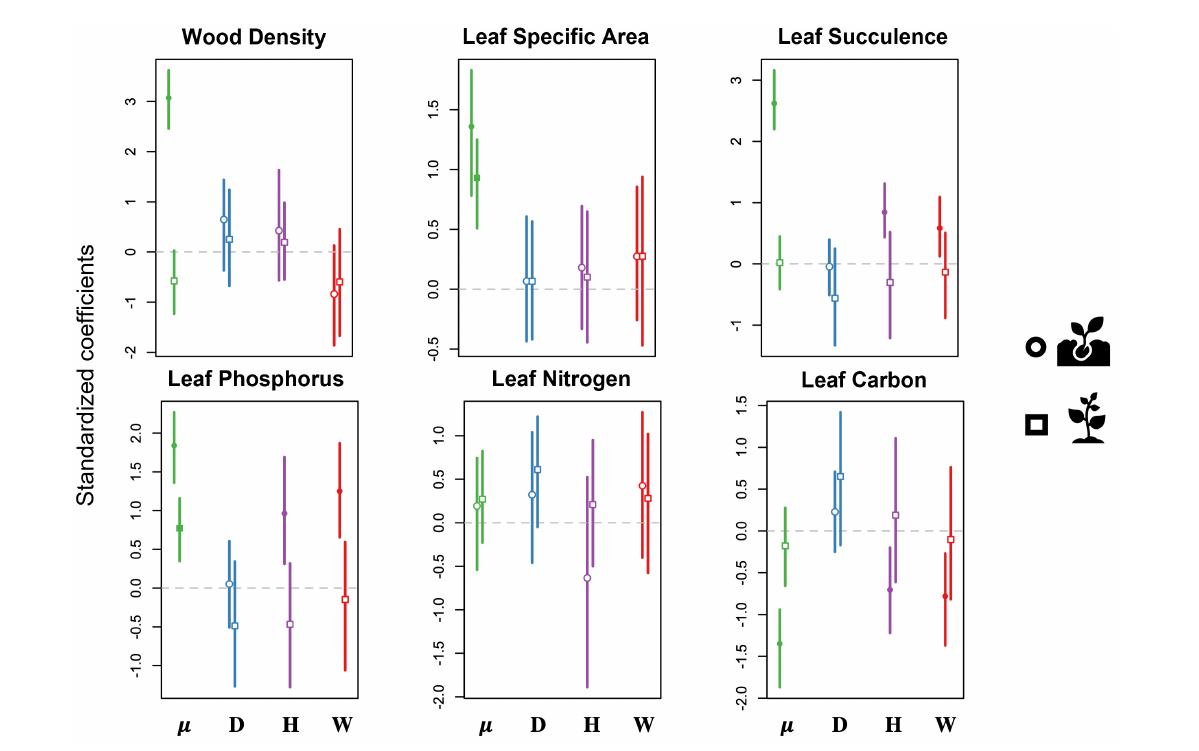
FIGURE5 Results of predictive trait modeling, showing the predicted effects of each disturbance type on the community-weighted means of functional traits for both seedlings (circles) and saplings (squares). Lines expand to the 95% credible intervals. Open symbols show non-significant effects (credible intervals overlap with 0), whereas filled symbols indicate significant effects. Data are shown for the intercept ( µ , green) and for drought (D, blue), hurricanes (H, purple), and warming (W, red). Traits include wood density (WD; g/cm 3 ), specific leaf area (SLA; cm − 2 /g 1 ), leaf succulence (LS; g H20/cm 2 leaf area), leaf phosphorous (P; percentage P of oven-dry mass), leaf nitrogen (N; percentage N of oven-dry mass), and leaf carbon (C; percentage C of oven-dry